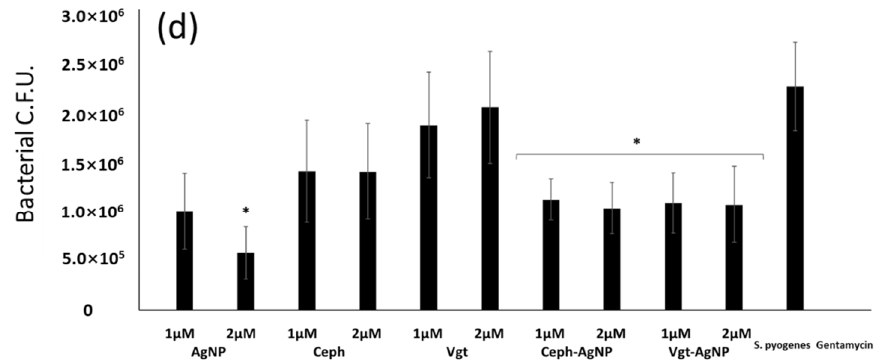
Figure 4. P. aeruginosa ( a ); K. pneumoniae ( b ); B. cereus ( c ); S. pyogenes ( d ). Bacterial colonies were determined following incubation with Cephradine and Vildagliptine. Briefly, 1 × 10 6 bacteria were incubated with drugs and controls at 37 °C for 24 h. Both drugs—conjugated AgNPs and Ag-NPS—alone exhibited significant bactericidal effects ( p < 0.05 using t -test, two-tailed distribution, as indicated by asterisk), while as there was no significant effects of drugs alone. The results are the mean ± standard error of three independent experiments performed in duplicate.